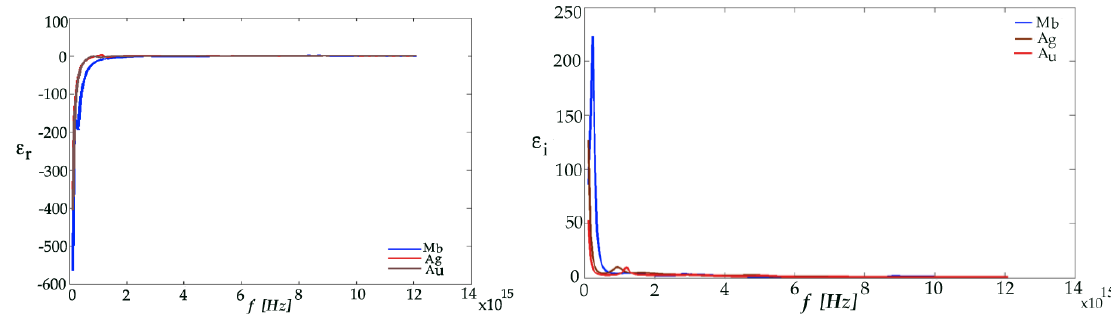
Figure 3. The real part ( left ) and the imaginary part ( right ) of the dielectric constant of various noble metals, such as Au, Ag and